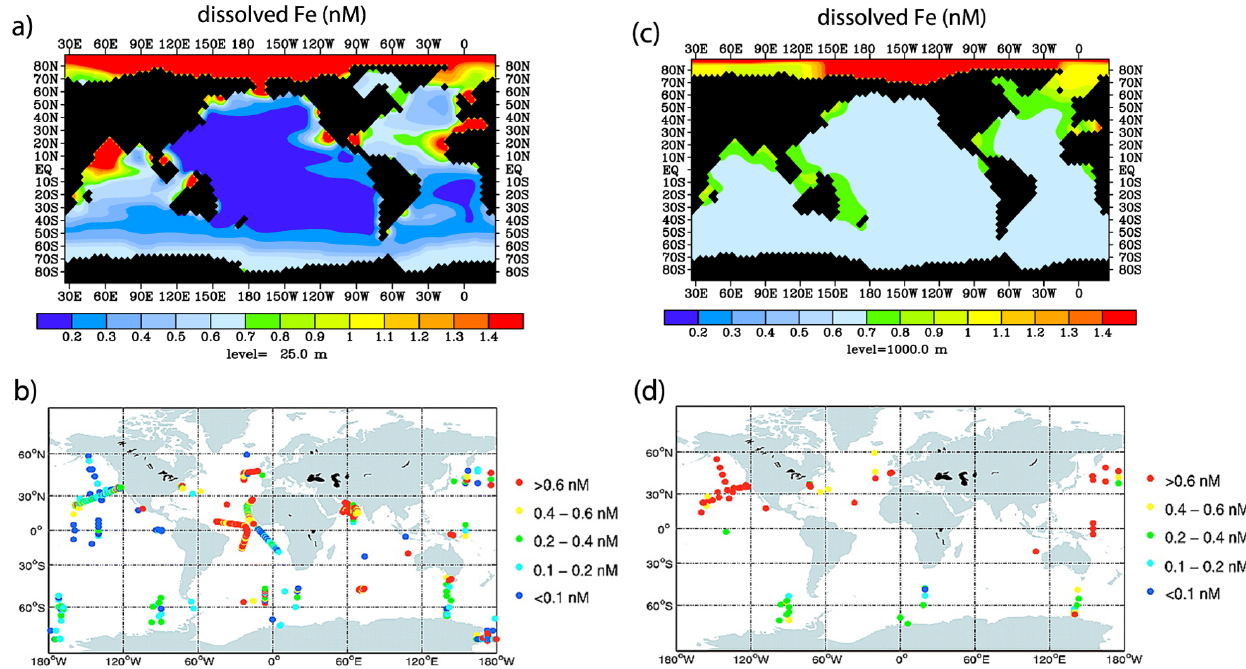
Fig. 1. Dissolved Fe concentrations (in nM) (a) in the surface ocean and (c) 1000-m depth as simulated in the model reference run. Observa- tions of dissolved Fe in (b) surface waters (0 to 25m) and (d) intermediate waters (800 to 1100m) from Parekh et al. (2005).